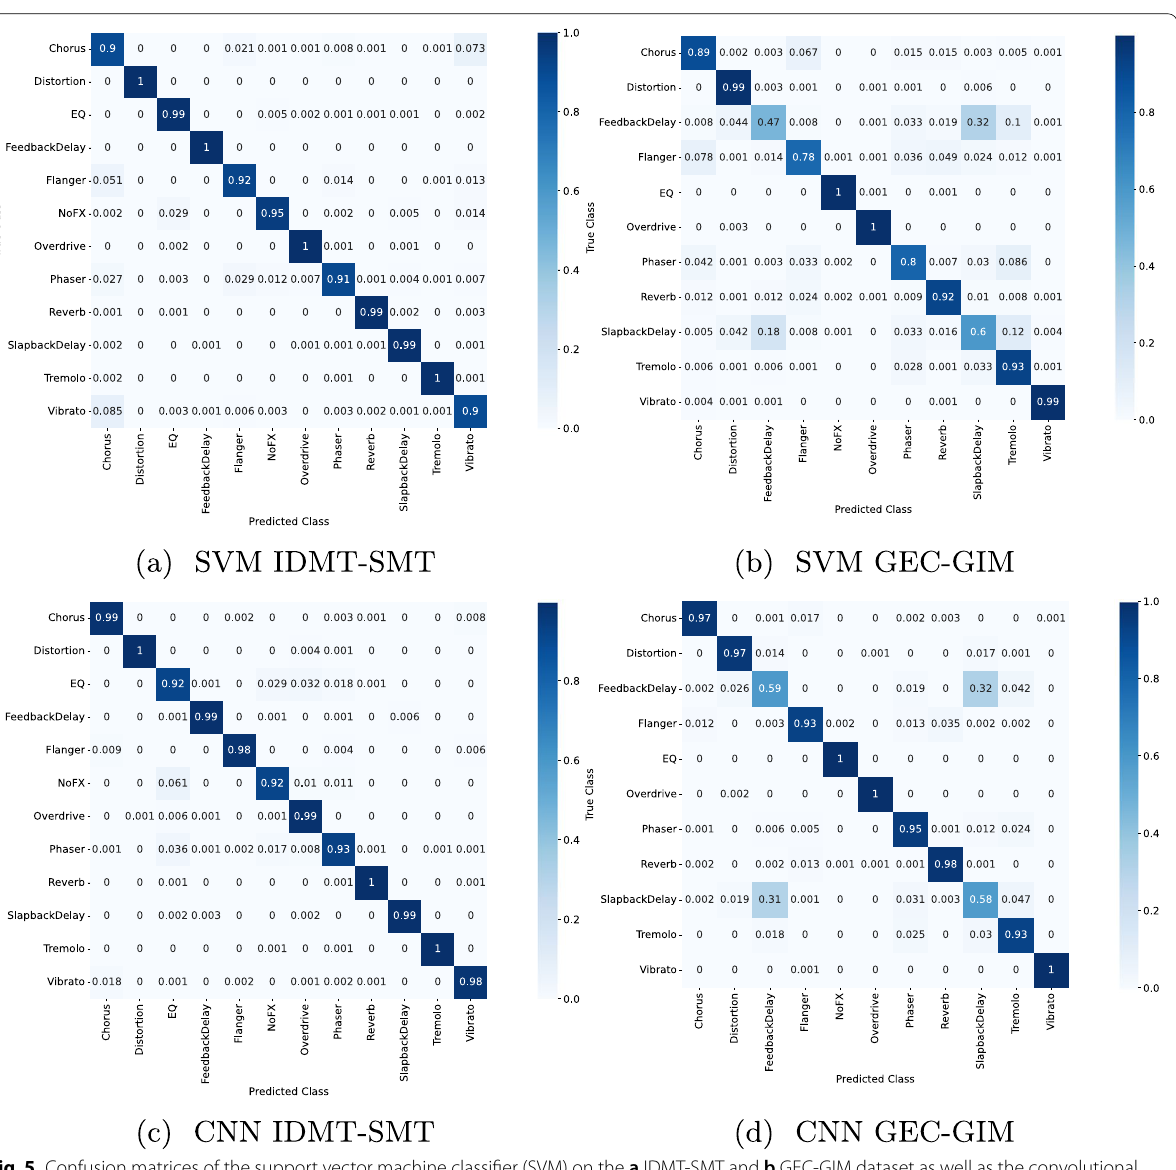
Fig. 5 Confusion matrices of the support vector machine classifier (SVM) on the a IDMT-SMT and b GEC-GIM dataset as well as the convolutional neural network (CNN) classifier on the c IDMT-SMT and d GEC-GIM dataset. On the GEC-GIM, both classifiers tend to confuse slapback and feedback delay which was due to random settings of the feedback parameter. For feedback settings below at least 0.3, slapback and feedback delay indeed were very difficult to distinguish which was confirmed through selected listening